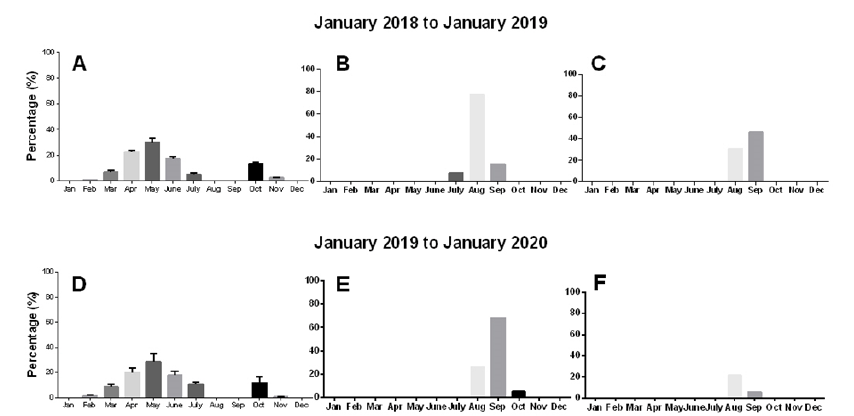
Figure 7. ( A–C ) Phenology of sprouting and floral bud formation in H. hundatus in Pisa (Italy). Data from January 2018 to January 2019 ( A–C ) and data from January 2019 to January 2020 ( D–F ). Total sprouting rate (represented as means of n = 30 plants. ( A,D ), floral bud formation rate ( B,E ), and floral bud abortion rate ( C,F ) were 100% within the period considered.